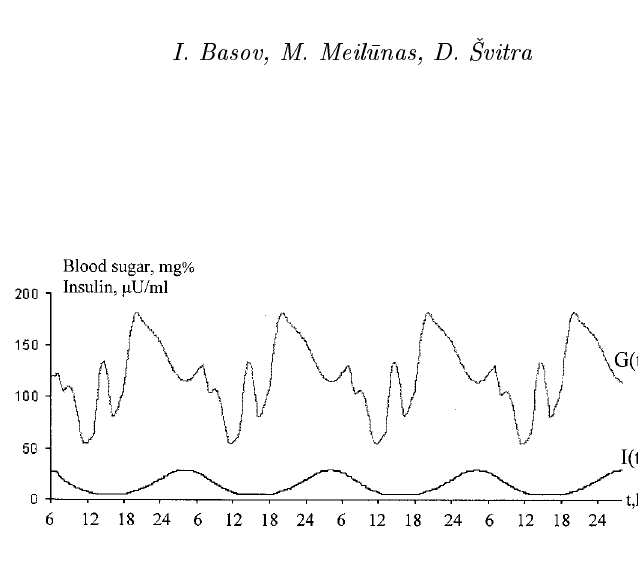
Figure(cid:8)(cid:1)InthemorningLente(cid:9)SemilenteandRegularinsulin(cid:8)